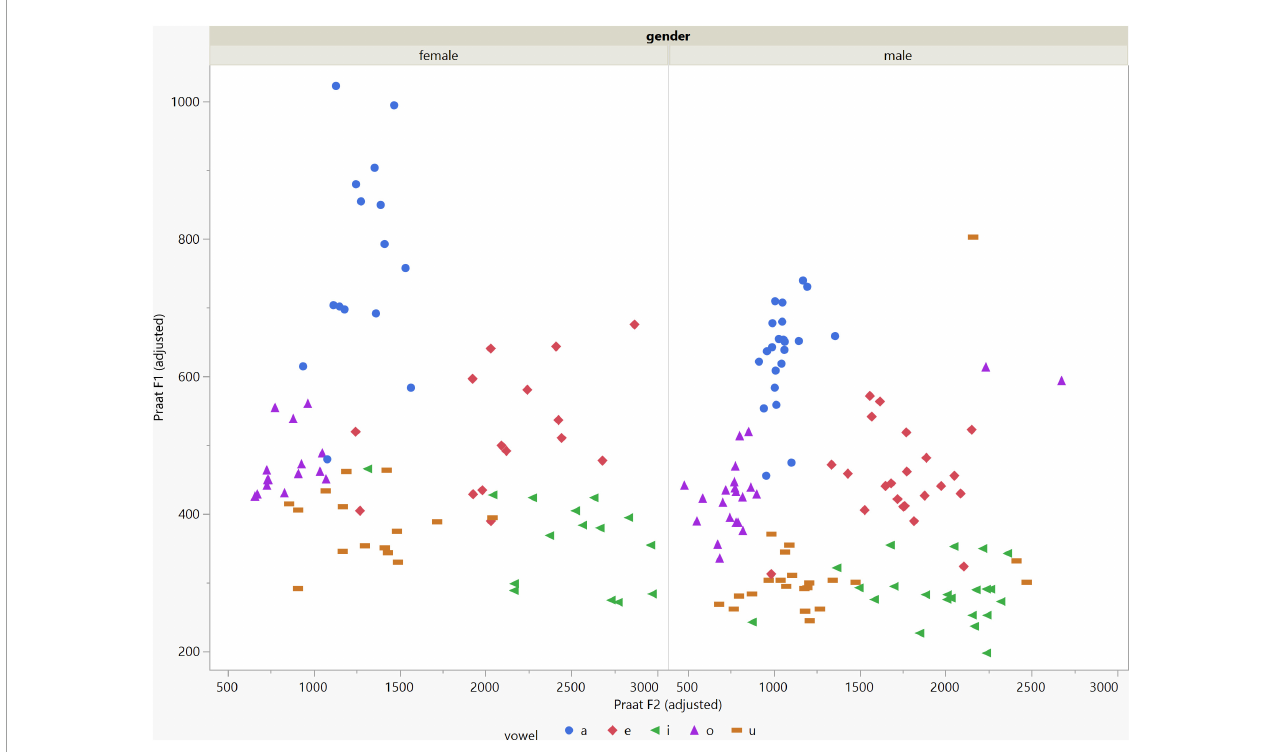
FIGURE4 Arrangement of the F1 and F2 data of the five vowels calculated using Praat with the adjusted settings. The data for females showed more scatter along the F1 and F2 axes compared with the data for males.